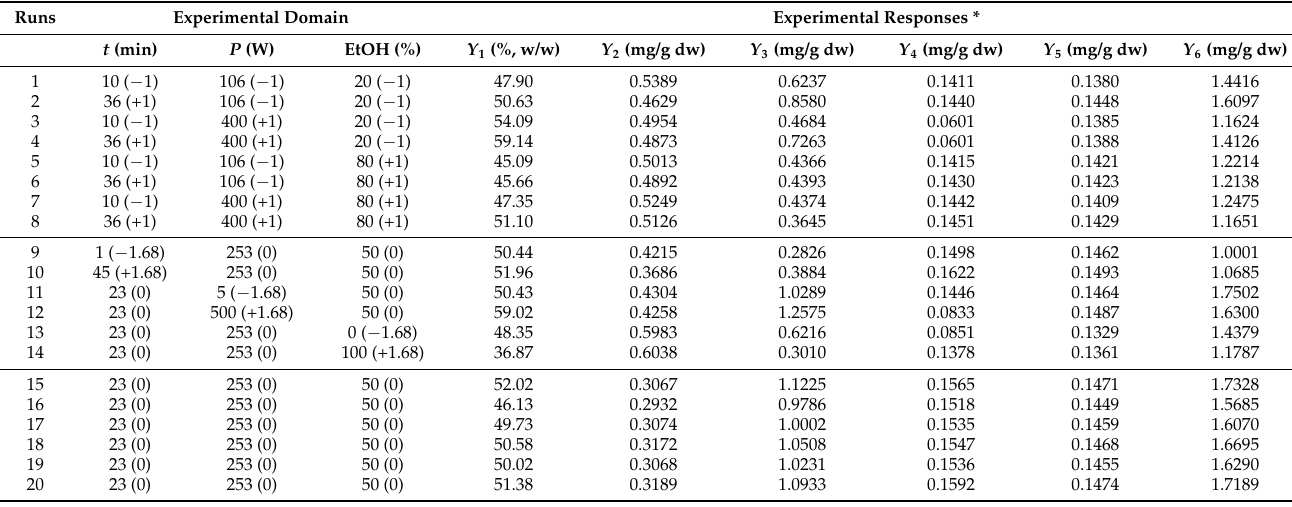
Table 2. Experimental responses obtained under the extraction conditions defined by the CCRD design matrix for the extraction yield and flavonoids